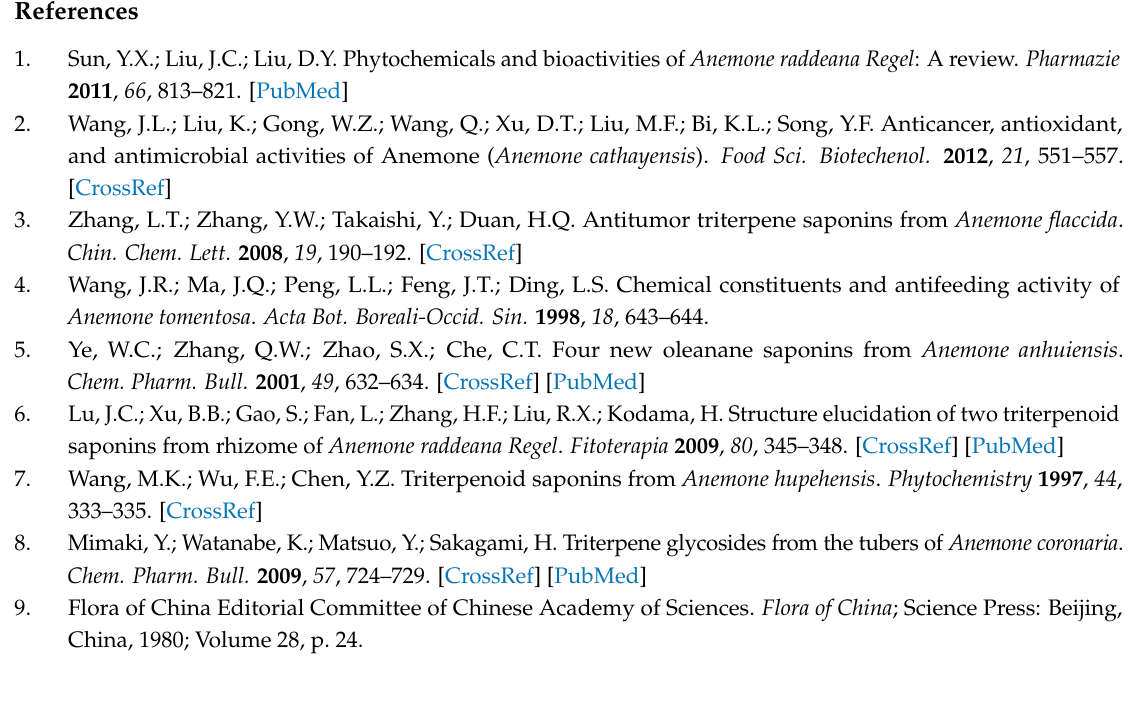
Figure S2. Key NOESY and HMBC correlations for compound 3 ; Figure S3. Key NOESY and HMBC correlations for compound 4 ; Figure S4. Key NOESY and HMBC correlations for compound 5